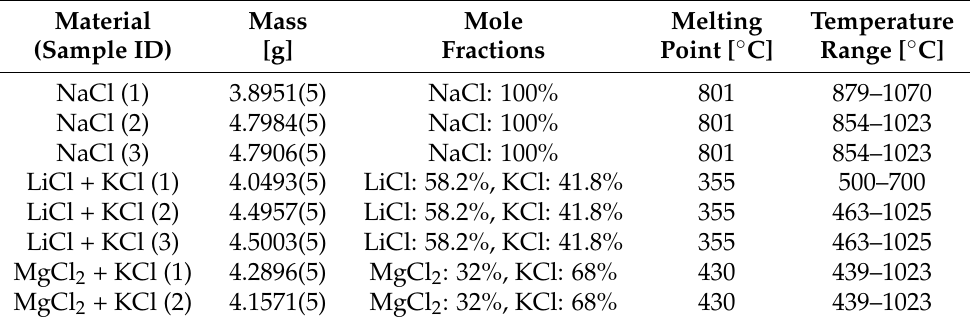
Table 1. List of samples used for density measurements with neutron radiography on FP5 at LANSCE, along with the mass of each sample, the mole fraction, melting point, and temperature range over which the density measurements were